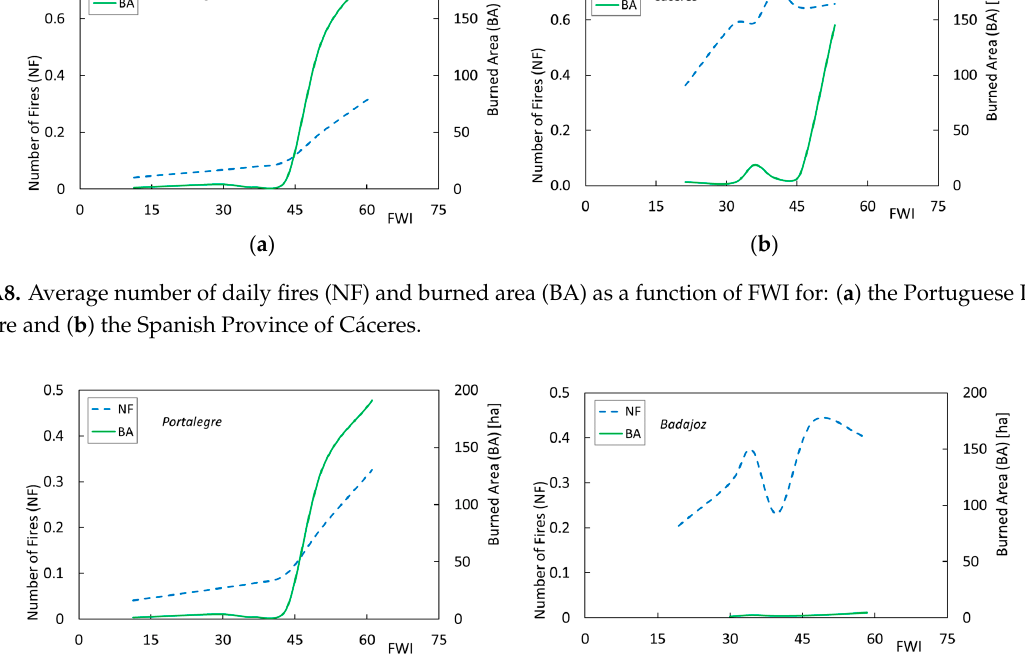
Figure A9. Average number of daily fires (NF) and burned area (BA) as a function of FWI for: ( a ) the Portuguese District of Portalegre and ( b ) the Spanish Province of Badajoz.